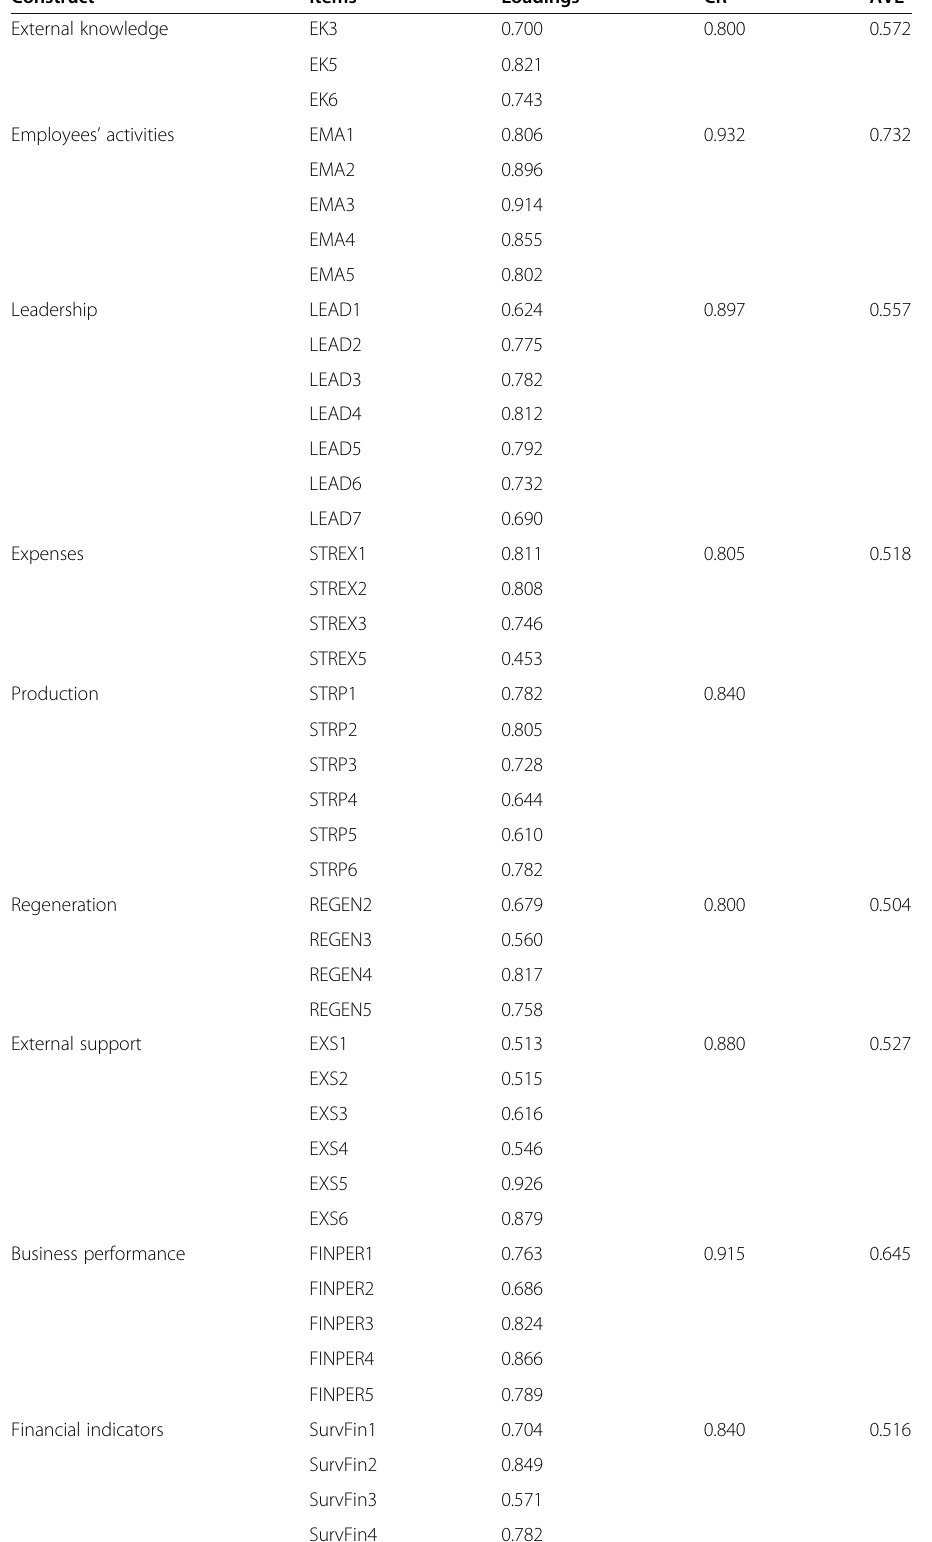
Table 1 Internal consistency, convergent validity, composite reliability, and